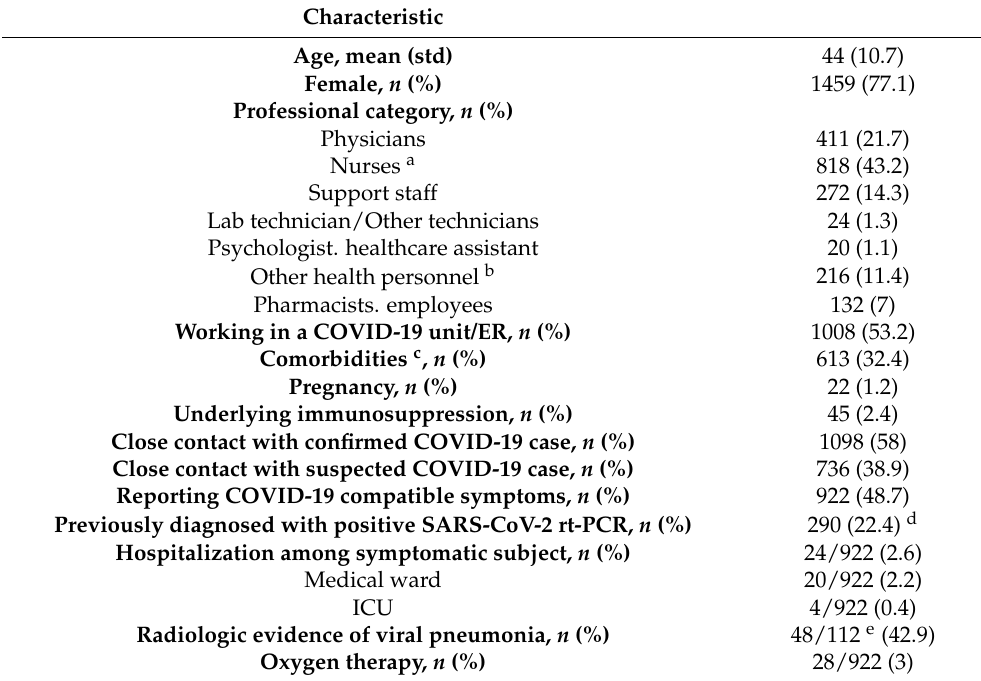
Table 1. Characteristics of study participants ( n =